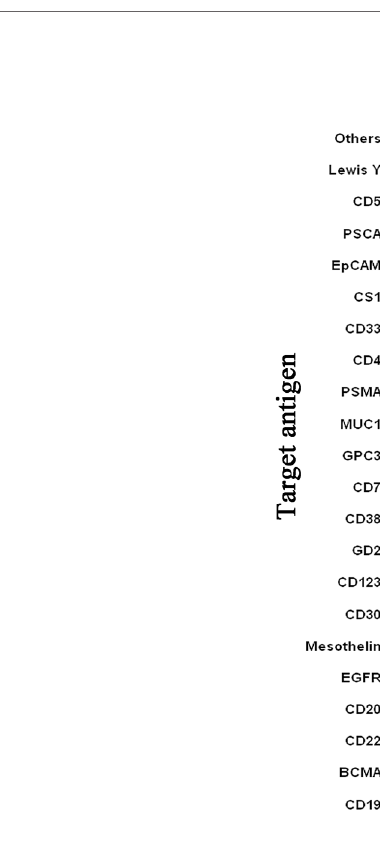
FIGURE 2 | Target antigens of CAR-T cell therapy using CRISPR-Cas9 gene-editing technology registered in ClinicalTrials.gov until June 2021. The data only include clinical trials that are registered in